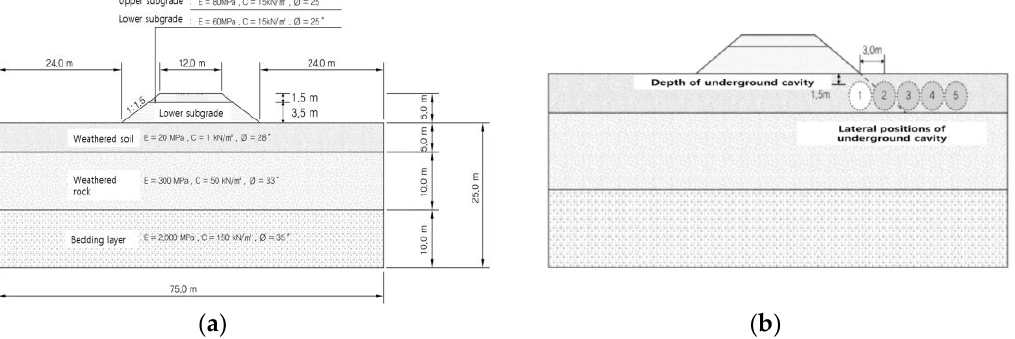
Figure 2. ( a ) Numerical analyses of geometric conditions and material properties conducted and ( b ) Parametric evaluations on the potions of underground cavity [12].